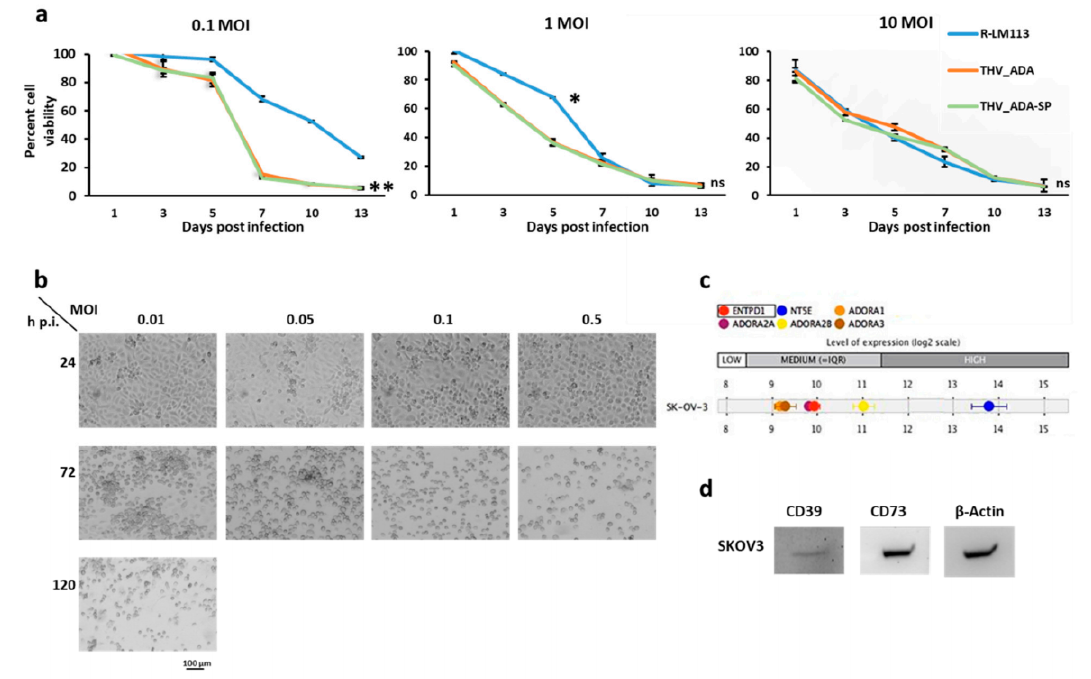
Figure 3. Cytotoxicity of THV_ADA and THV_ADA-SP. ( a ) The cytotoxic effect of R-LM113 (blue), THV_ADA (orange), and THV_ADA-SP (green) was assessed by Alamar Blue in SKOV3 infected at different MOI up to 13 days after infection. * and ** were, respectively, used to label p -value < 0.05 and <0.005. ( b ) Time-course evaluation (24, 72, 120 h post infection) by brightfield microscopy of THV_ADA-mediated cytopathic effect on SKOV3 cells infected at different MOI (0.01, 0.05, 0.1, 0.5 pfu/cell). Bar indicates 100 µ m. ( c ) Transcriptomic analysis by Genevestigator of CD39, CD73, and ADO receptors in SKOV3 cells. ( d ) Expression of CD39 and CD73 in SKOV3 cells was determined by Western Blot analysis. B-Actin was used as